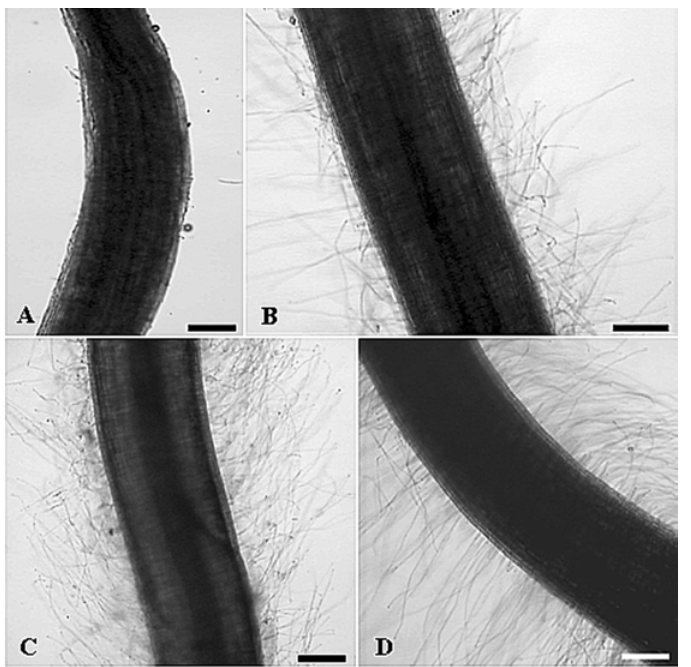
Fig. 6 – Effect of IAA produced by B. kururiensis on root hairs of O. sativa grown in vitro . Treated plants were incubated for 24 h in hydroponic media supplemented with ( A ) medium non-inoculated (500 μ l); ( B ) 50 μ M IAA standard; ( C ) 10 8 B. kururiensis cells; ( D ) filter-sterilized culture supernatants of B. kururiensis . Bar = 200 μ